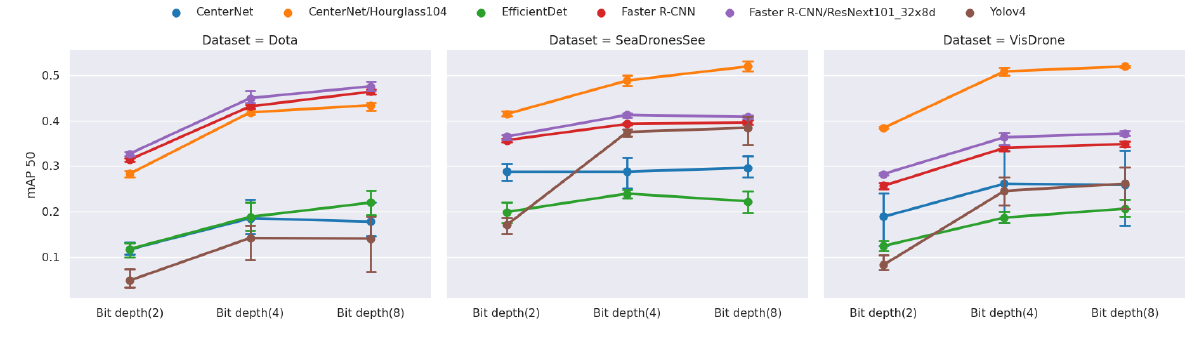
Figure 5. Quantization: the impact of the quantization on the performance of the object detectors for all data sets. The y-axis shows the mean Average Precision (mAP).